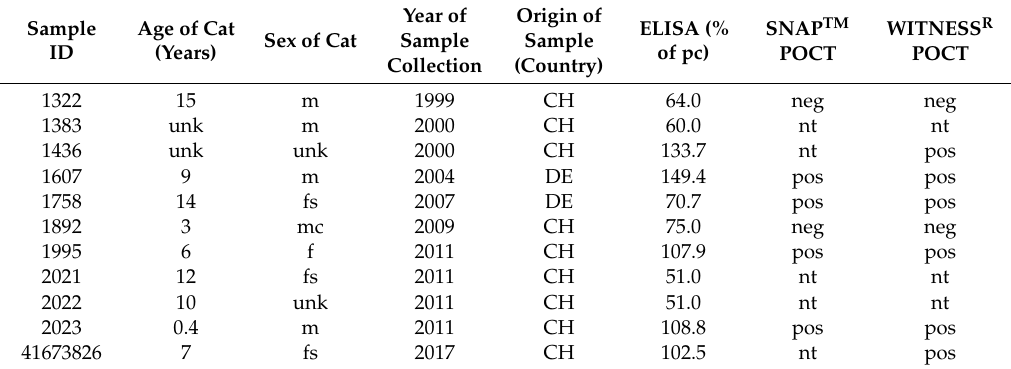
Table 3. Characteristics of the 11 false ELISA-positive samples (FIV WB-Negative and FIV-TM ELISA-Positive).